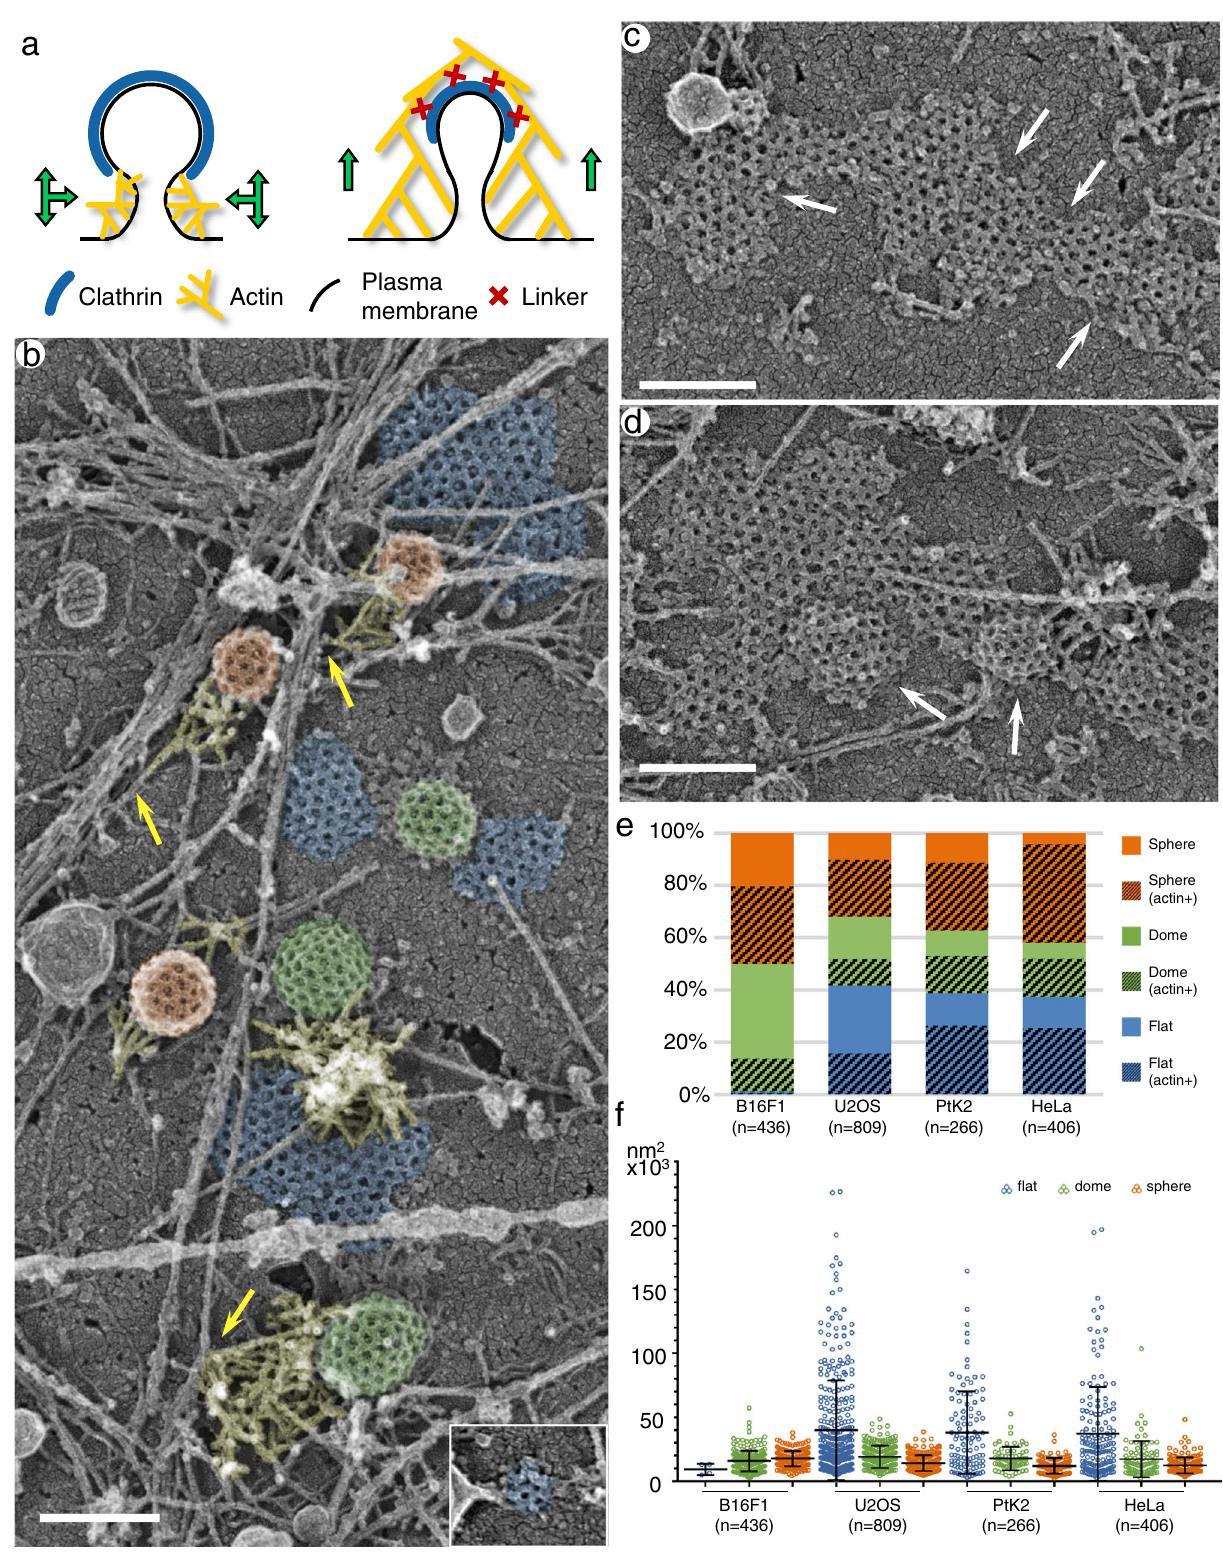
Fig. 1 | PREM analysis of CCS morphology. a Two alternative models for actin- dependent invagination of CCSs. (Left) Edgepushing model. (Right) Apical pulling model. b A region of an unroofed U2OS cell showing fl at (blue), dome-shaped (green) and spherical (orange) CCSs, some of which associate with branched actin networks (yellow). Arrows mark linear actin fi laments from which branched net- works originate. Inset shows a very small fl at CCS. c Large fl at CCSs in U2OS cells